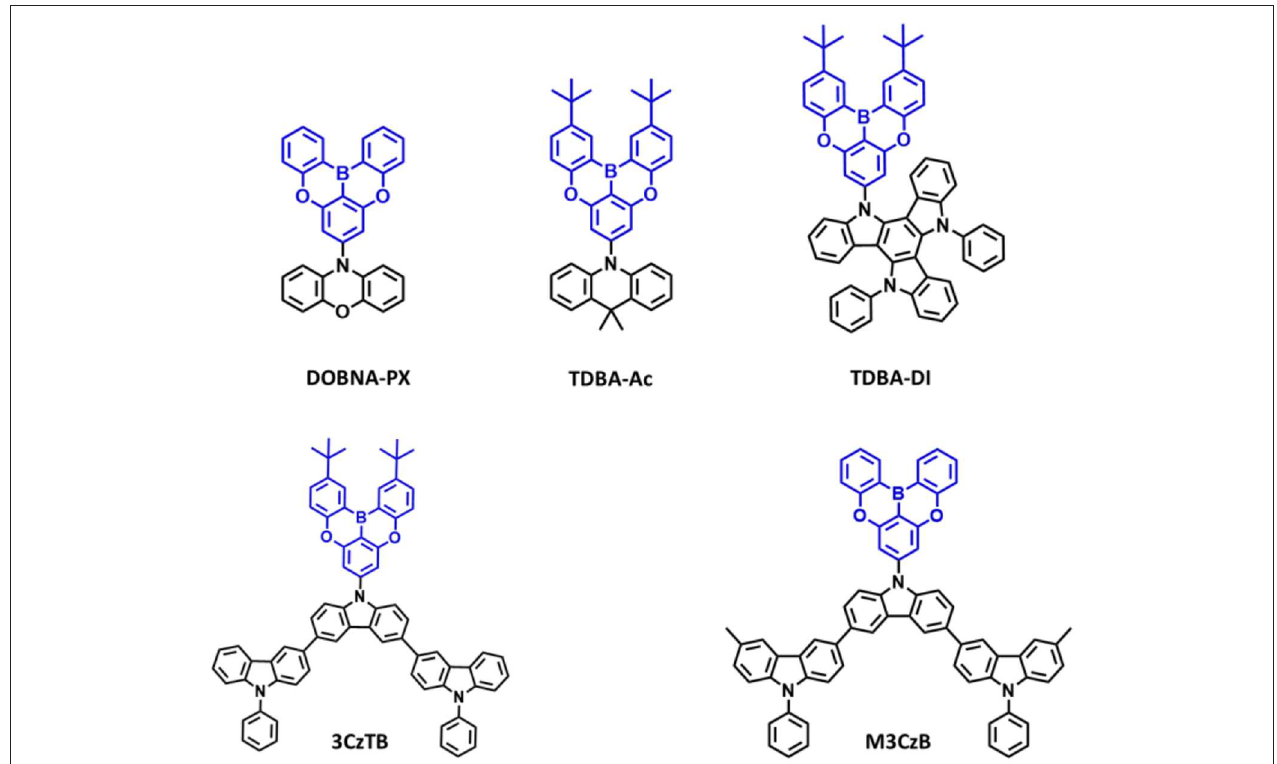
FIGURE 6 | Reported structures of blue thermally activated delayed fluorescence (TADF) emitters using oxygen-based fully bridged boron acceptor and different